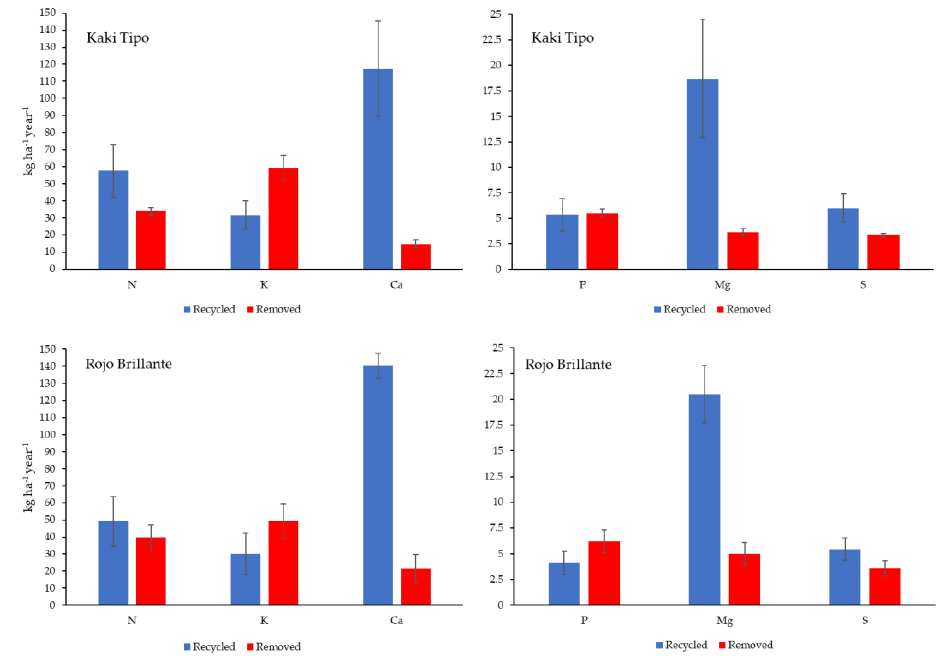
Figure 5. Amounts of macronutrients recycled and removed in mature persimmon orchard. Recy- cled nutrients: abscised leaves + pruned wood; removed nutrients: fruits + roots and skeleton. Means ± SD ( n = 20 for leaves, fruits and pruned wood, and 4 for skeleton and roots). The sum of the two fractions shows the annual requirements of the orchard; that are, on average: 90 kg N ha −1 , 10.5 kg P ha −1 , 85 kg K ha −1 ; 147 kg Ca ha −1 ; 24 kg Mg ha −1 and 9 kg S ha −1 (Table 5). Table 5. Total annual demand of macronutrients (kg ha −1 year −1 ) of mature persimmon orchard. Total Demand